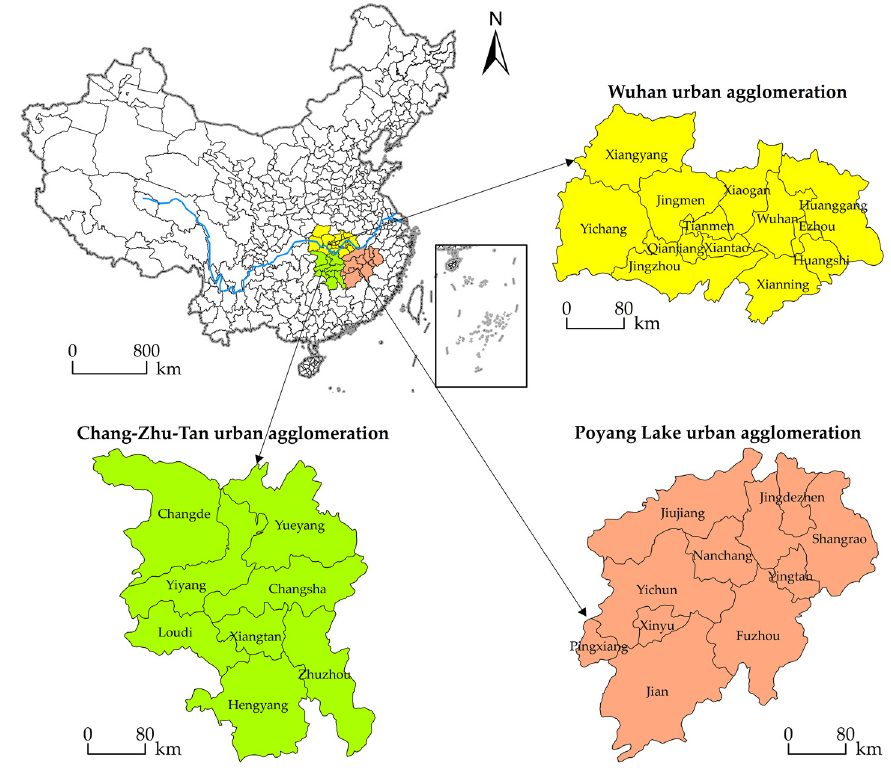
Figure 2. Location and range of the UAMRYR and its sub-urban